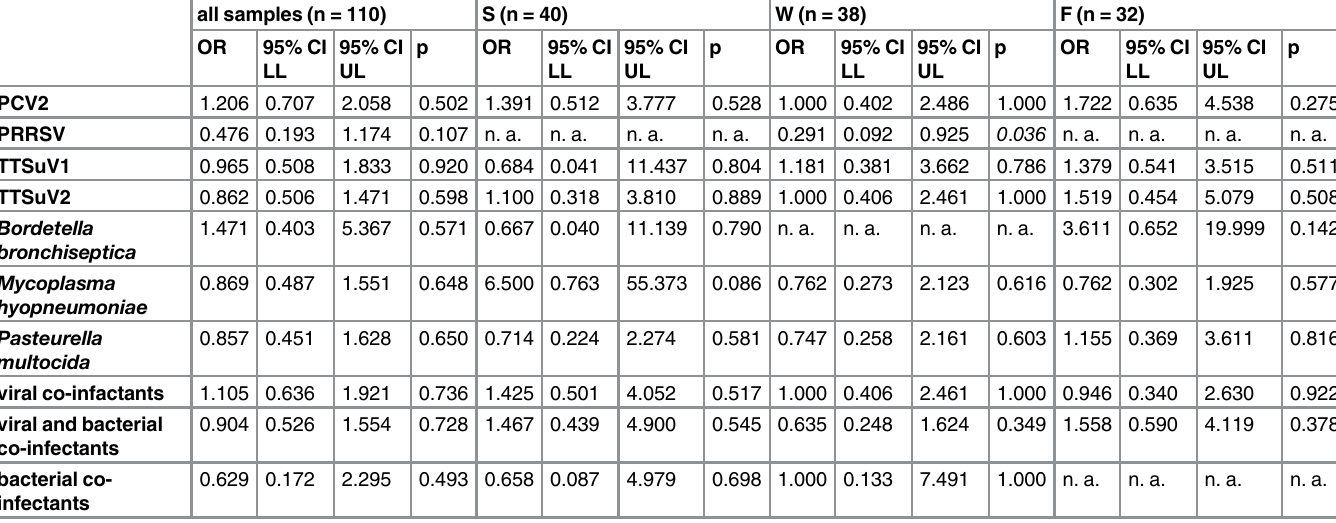
Table 5. Odds ratios of Pneumocystis spp. positive cases for co-infections with the other pathogens. S = suckling piglets, W = weaning piglets, F = fattening pigs; n = number of samples; OR = odds ratio, CI = confidence interval, LL = lower level, UL = upper level; p = level of significance; italic = p (cid:2)